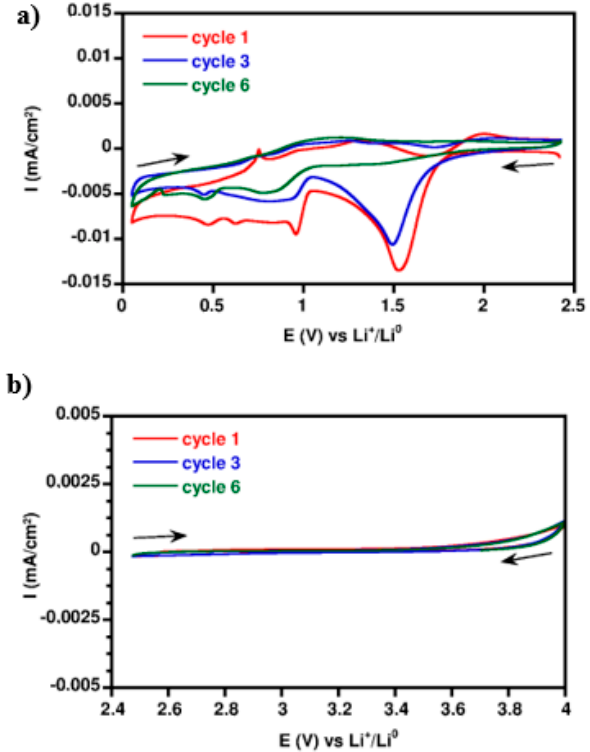
Figure 7. Cyclic voltammetry of gelled electrolyte prepared with 70 wt % of electrolyte ( a ) in reduction to 0.05 V vs. Li + /Li 0 and ( b ) in oxidation to 4 V vs. Li + /Li 0.